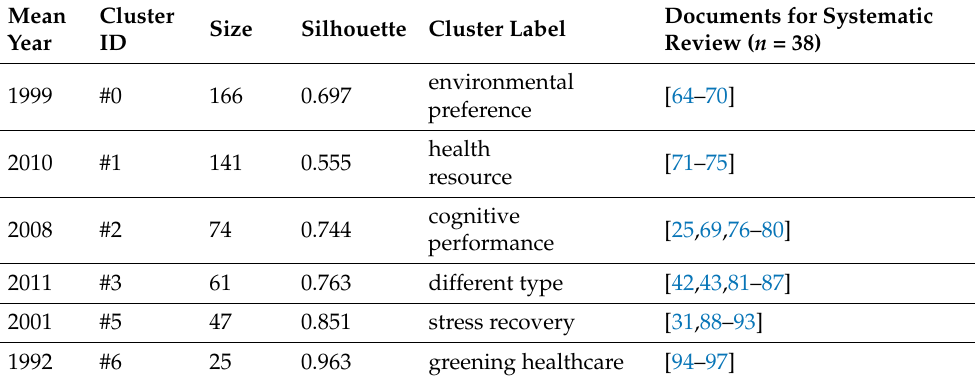
Table 3. Cluster information and documents for the first step of the systematic review, visual